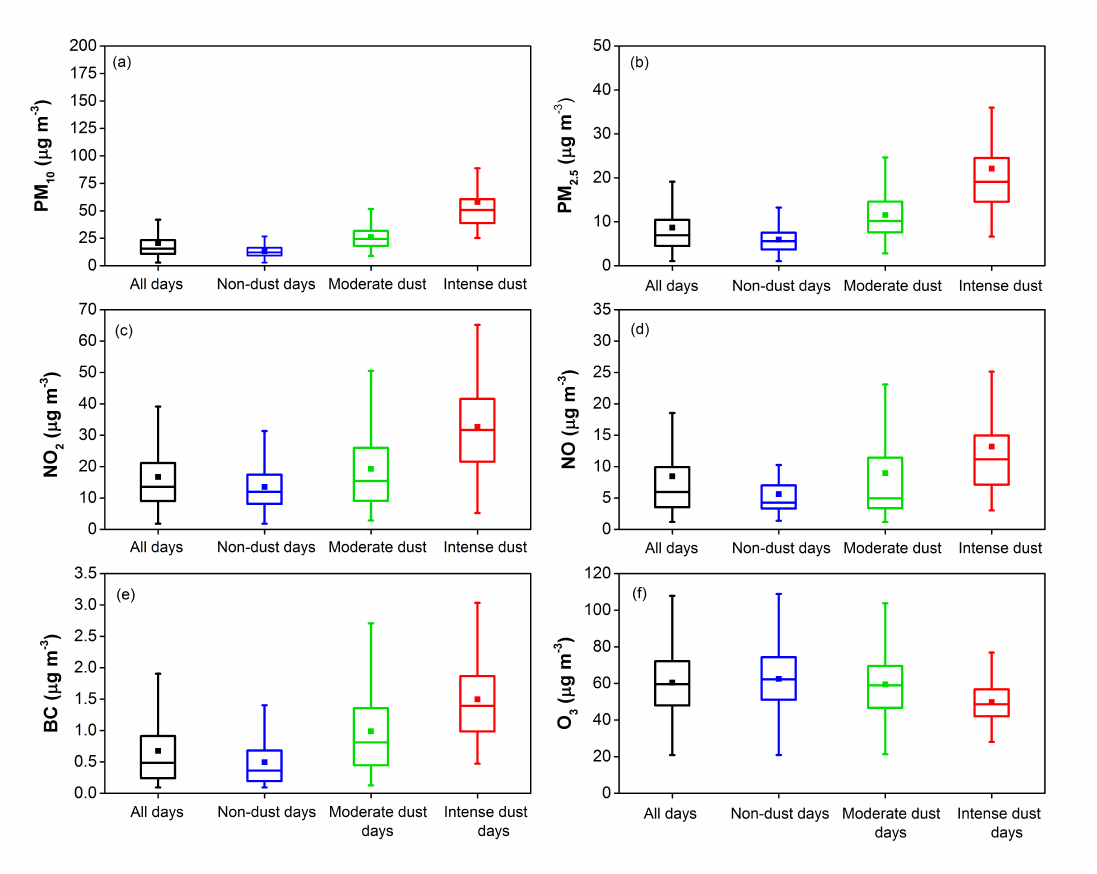
Figure 8. Same as Figure 7 but for the summer season